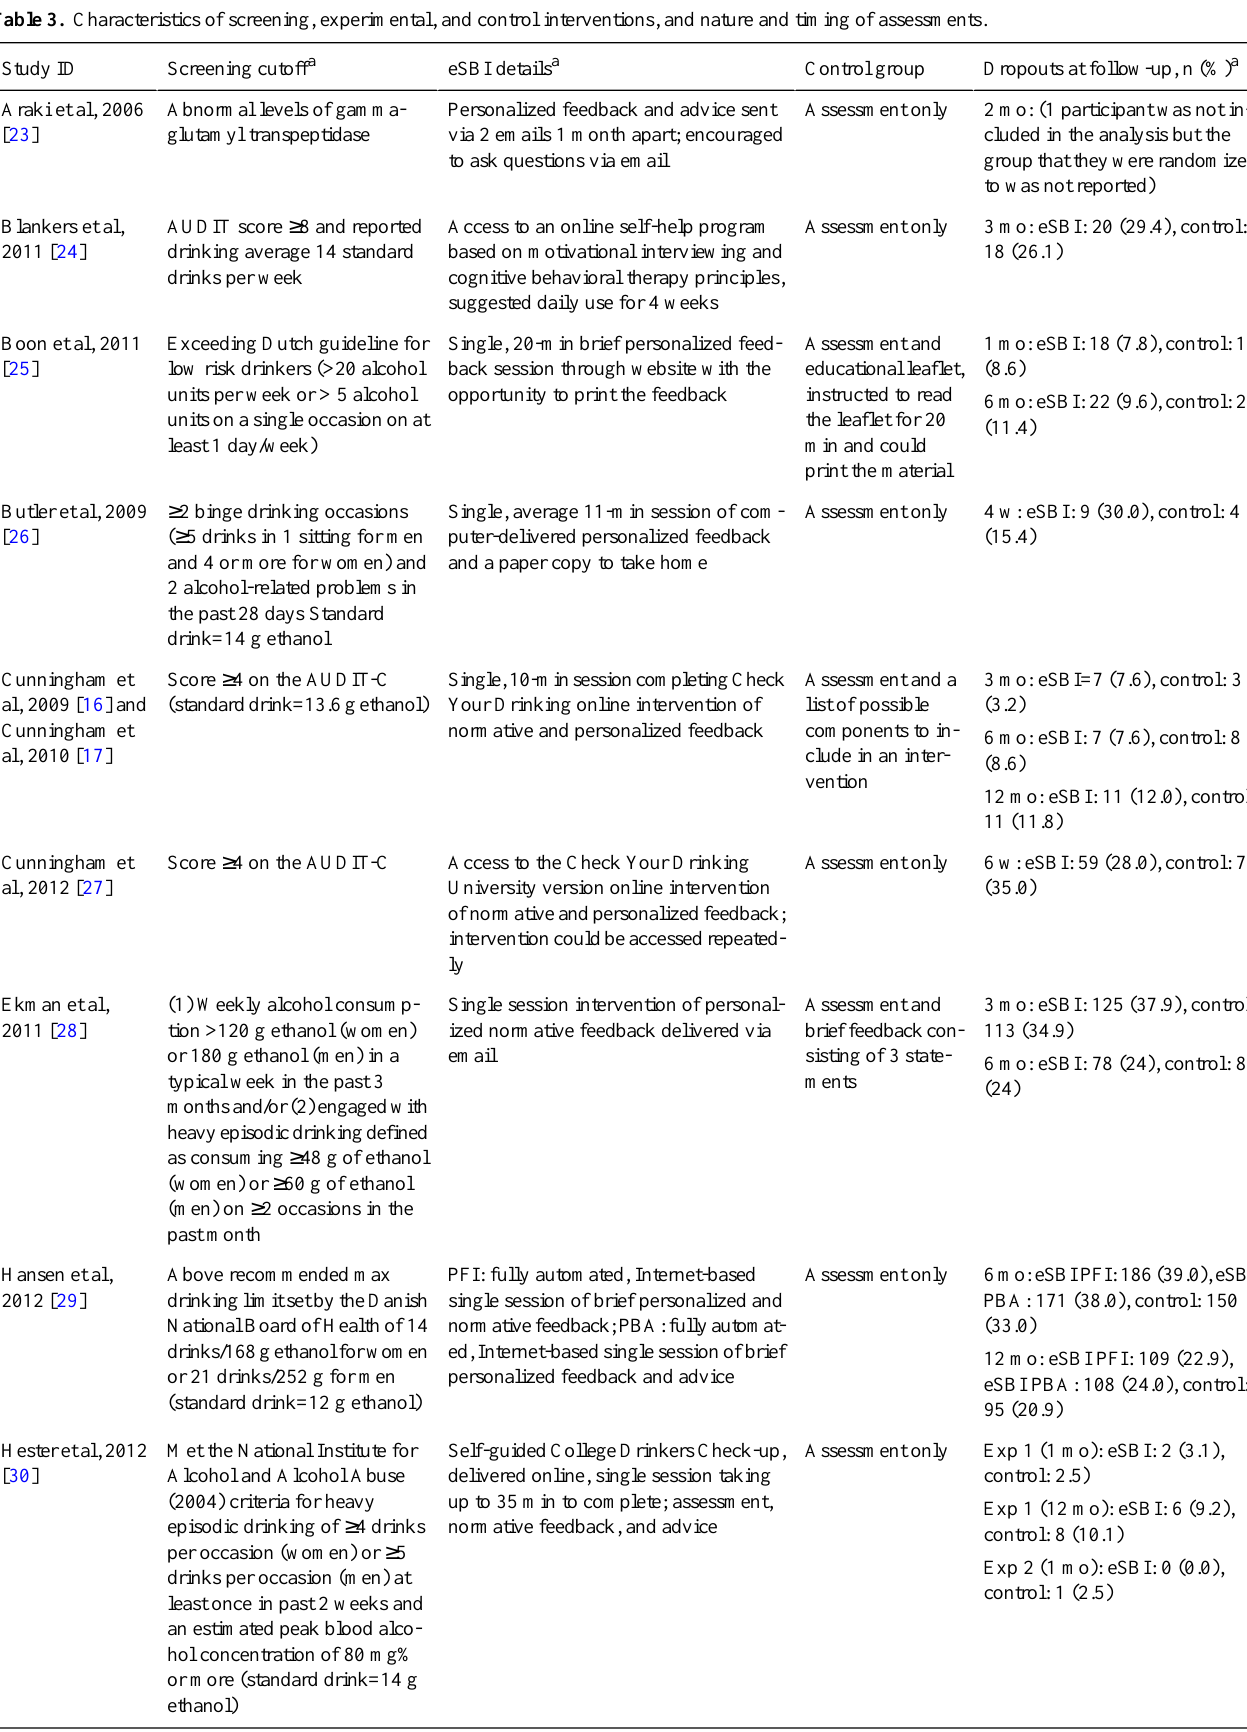
Table 3. Characteristics of screening, experimental, and control interventions, and nature and timing of